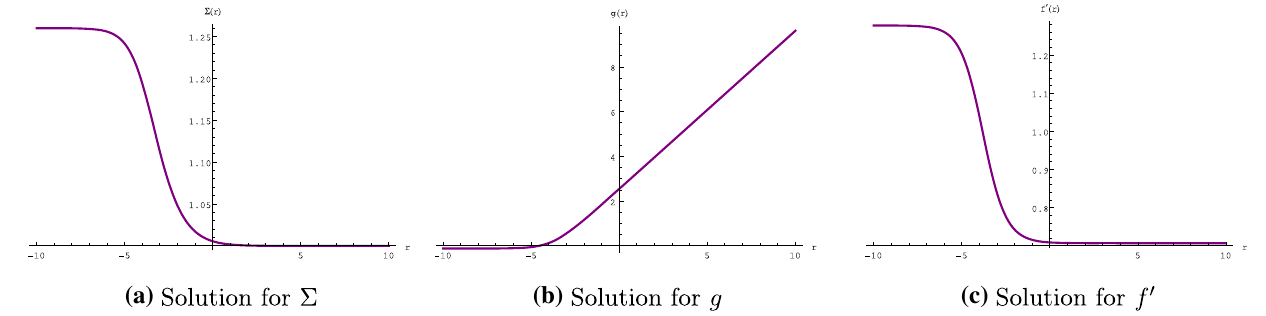
Fig. 11 An RG flow solution from AdS 5 with U ( 1 ) × SO ( 3 ) symmetry to N = 4 AdS 3 × H 2 geometry in the IR for U ( 1 ) × SL ( 3 , R ) gauge group and g 1 =